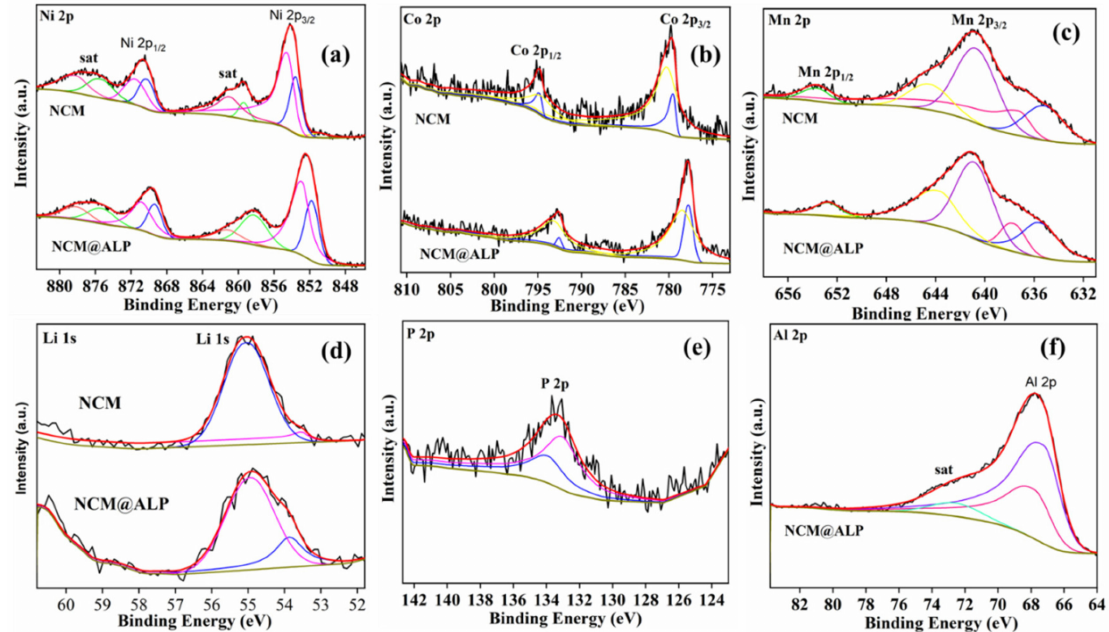
Figure 4. XPS spectra for NCM811 and NCM811@ALP500, ( a – d ) XPS spectra of Ni, Co, Mn, and Li for NCM811 and NCM811@ALP 500 samples, ( e – f ) XPS spectra of P and Al elements